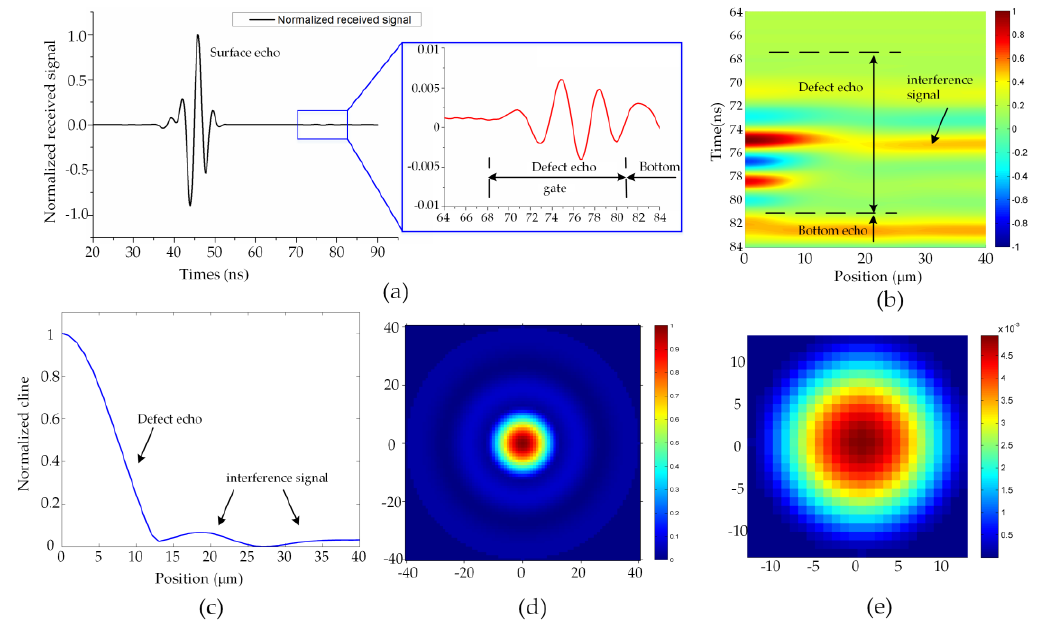
Figure 3. The A-scan, C-scan, and PSF (unit in µ m): ( a ) A-scan of the model with the transducer at position 0 µ m; ( b ) B-scan like image; ( c ) C-line; ( d ) C-scan; ( e ) PSF extracted from ( d ).